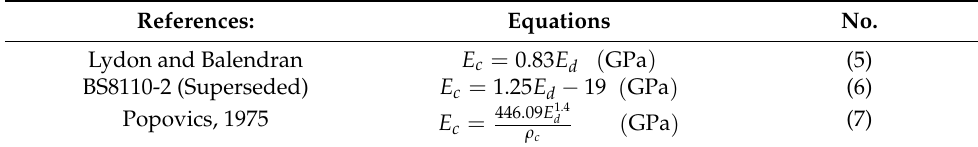
Table 2. Relationship between dynamic and static elastic modulus, adapted from Neville, 2011 [43].